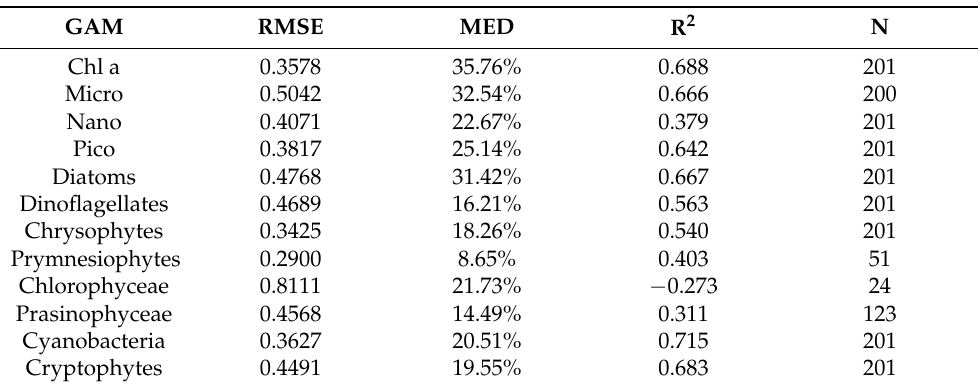
Table 14. Training results of the GAM. Note: RMSE, MED, R 2 , and N represent the root mean squared error, median absolute percentage error, coefficient of determination, and number of samples, respectively. The adjusted R 2 statistic can take on any value less than or equal to 1, with a value closer to 1 indicating a better fit. Negative values can occur when the model contains terms that do not help to predict the